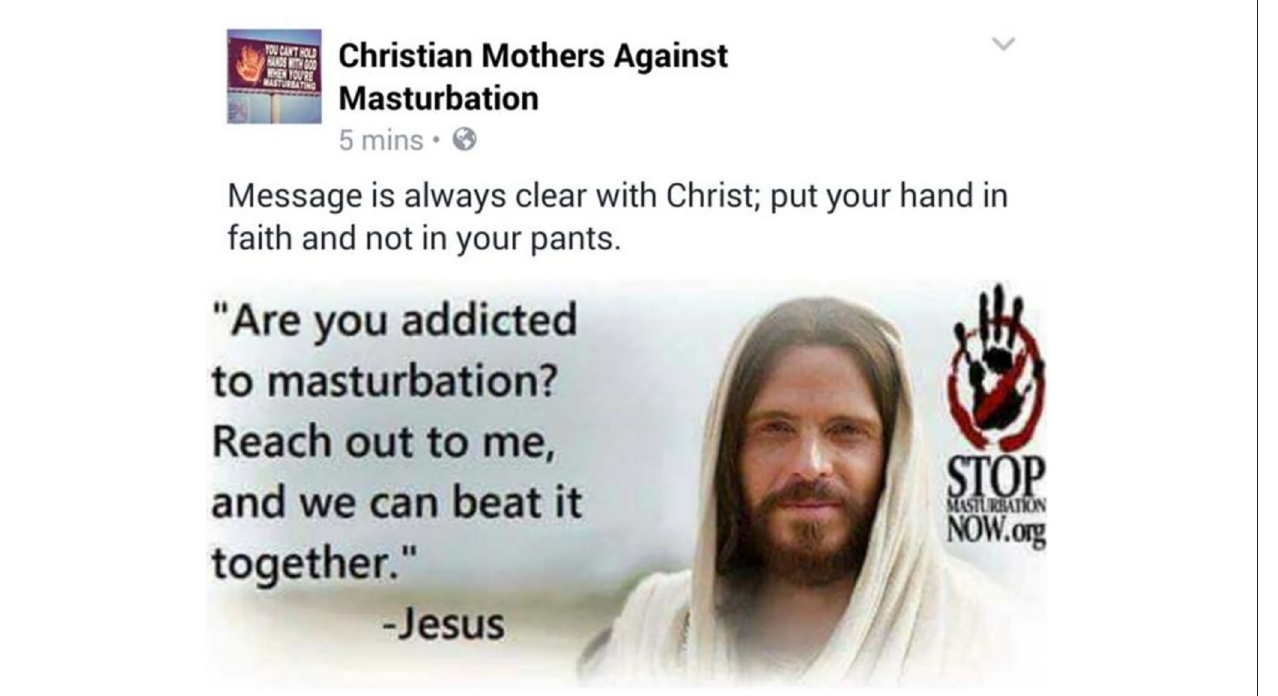
FIGURE 2 | Jesus- We can beat it together